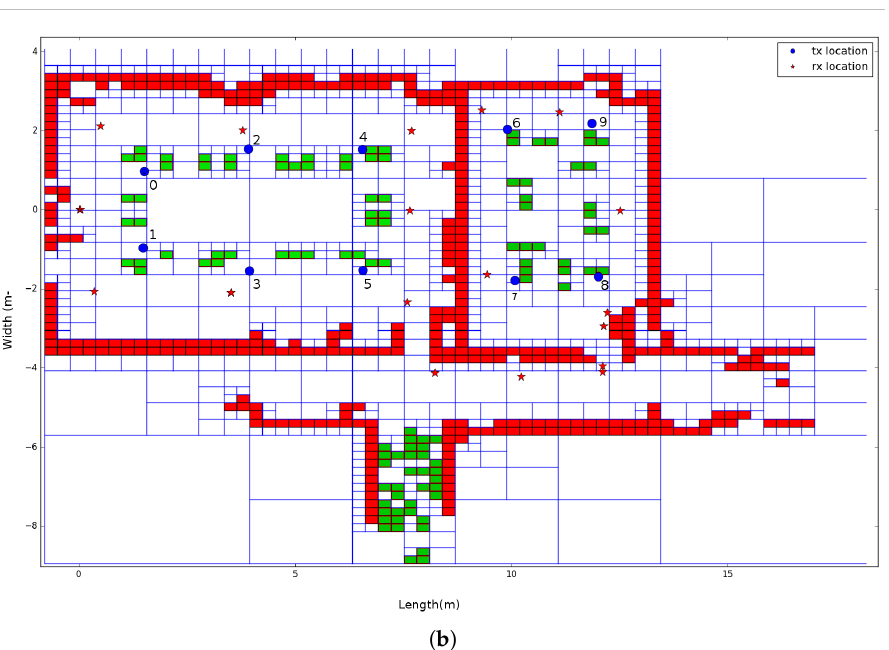
Figure 14. iGent Tower. ( a ) SLAM results; ( b ) environment model with transmitter and receiver locations.